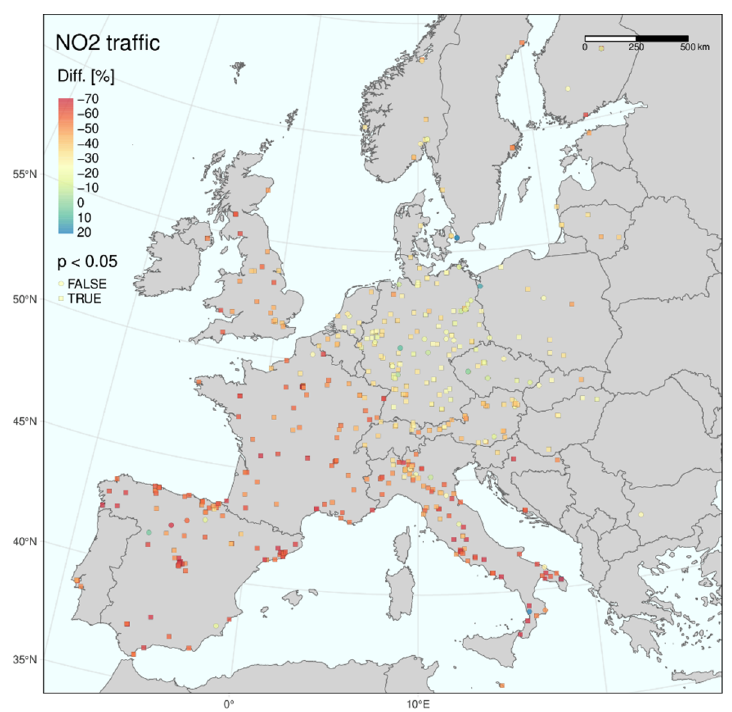
Figure 3. The lockdown impact in April 2020 is given by the difference between the measured and predicted mean NO 2 concentration for traffic sites. Stations with a statistically significant change ( p < 0.05) are shown as squares, other with circles.